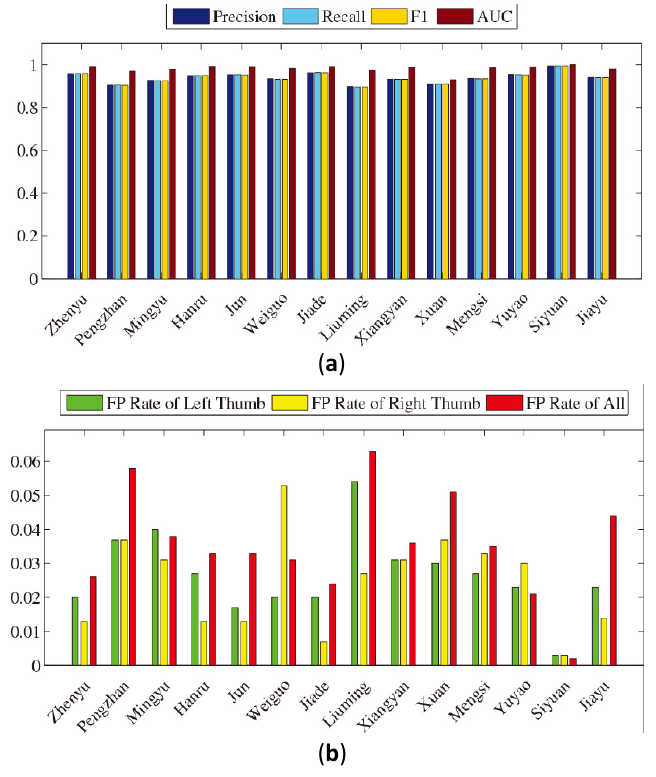
Figure 10. ( a , b ) Evaluation results of 14